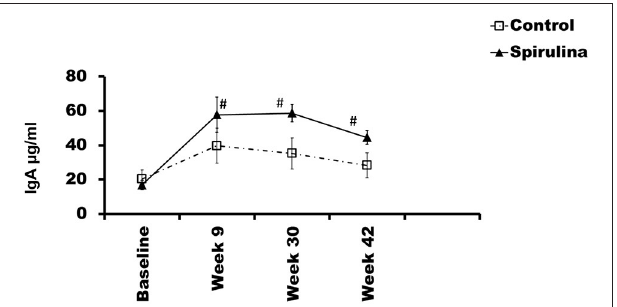
FIGURE 2 | GALT response: Changes in fecal IgA in each group during the trial are depicted as mean fecal IgA values ± SEM. X-axis depicts time in weeks and Y-axis depicts mean fecal IgA values in µ g/ml. # p < 0.05.